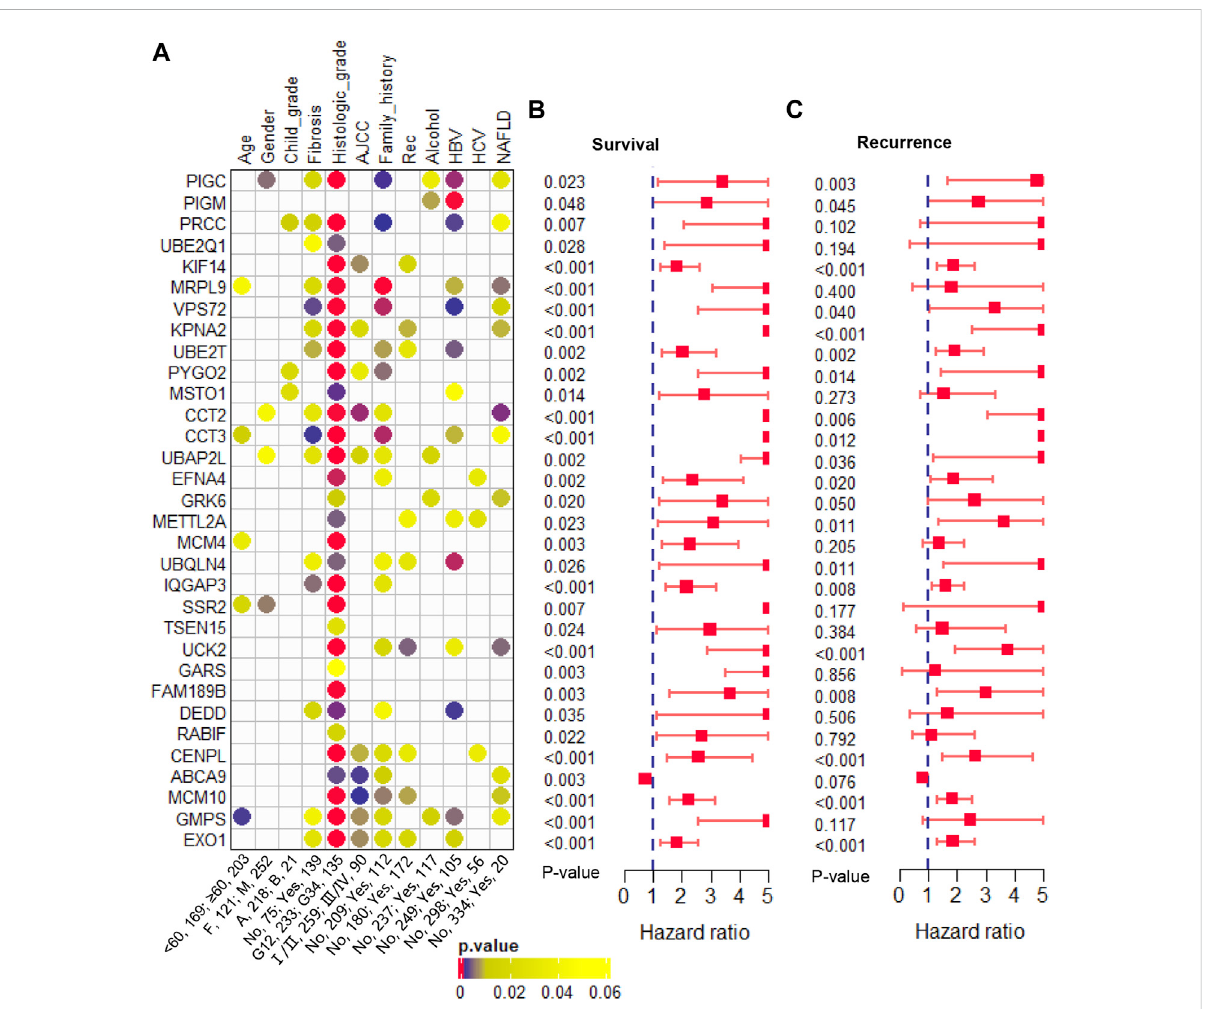
FIGURE 5 Clinical phenotype analysis (A) . The correlation of the candidate genes and clinical phenotypes (B) . The hazard ratio and p -value of the candidate genes in overall survival predicting (C) . The hazard ratio and p -value of the candidate genes in recurrence-free survival